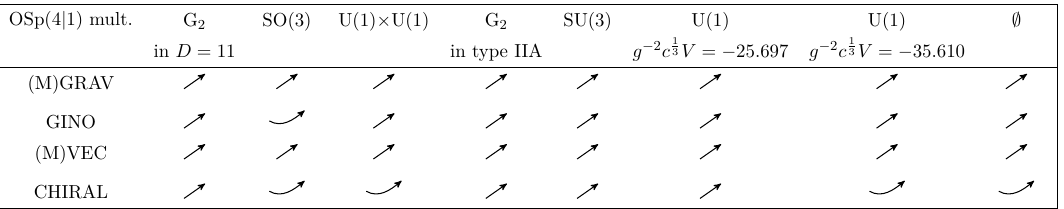
Table 2 . Monotonicity ( ) or non-monotonicity ( ) of E min the KK spectra of all N = 1 solutions of table